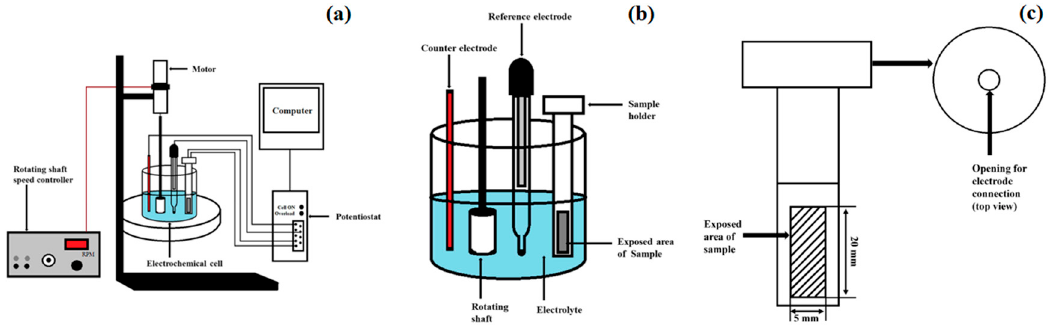
Figure 1. ( a ) Erosion-corrosion test set-up ( b ) erosion-corrosion chamber, ( c ) schematic diagram of the sample holder for the erosion-corrosion test.